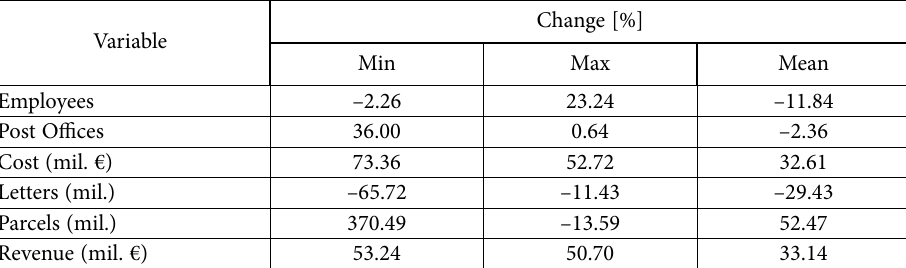
Table 3. Percentage changes of input and output variables for the period 2003–2017 (source : calculated by the authors based on data from Universal Postal Union (2019))